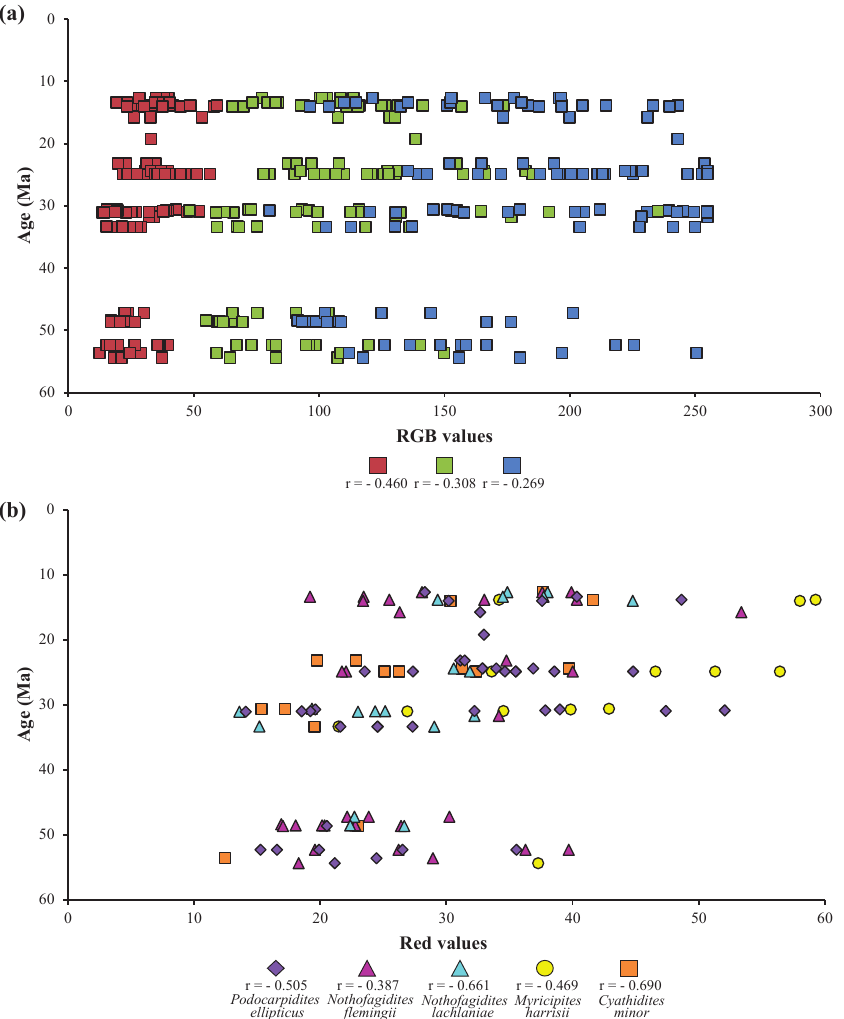
Figure 4. (a) All measured RGB fluorescence values for the 120 grains sampled in the Eocene, early Oligocene, late Oligocene, and Miocene plotted against age. The Pearson’s correlation coefficient values of fluorescence variables show the strength of the relationship between each fluorescence colour (red, green, and blue) and age. (b) Red-fluorescence values of each measured grain categorized by taxon ( Cyathidites minor , Myricipites harrisii , Nothofagidites flemingii , N. lachlaniae , Podocarpidites ellipticus ) and plotted versus age along with Pearson’s correlation coefficient to indicate the correspondence between the red values of each taxon and age.